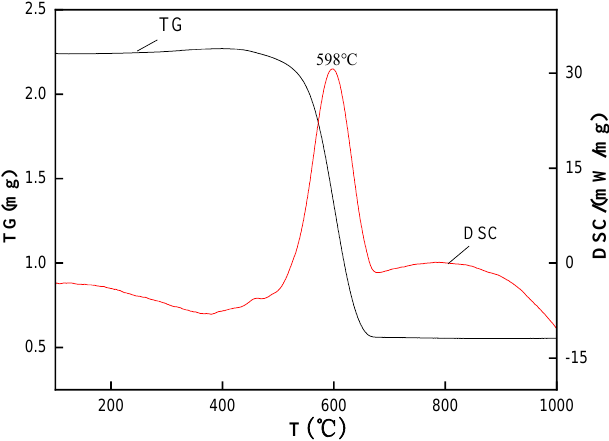
Figure 4. TG – DSC chart of the coal gangue.